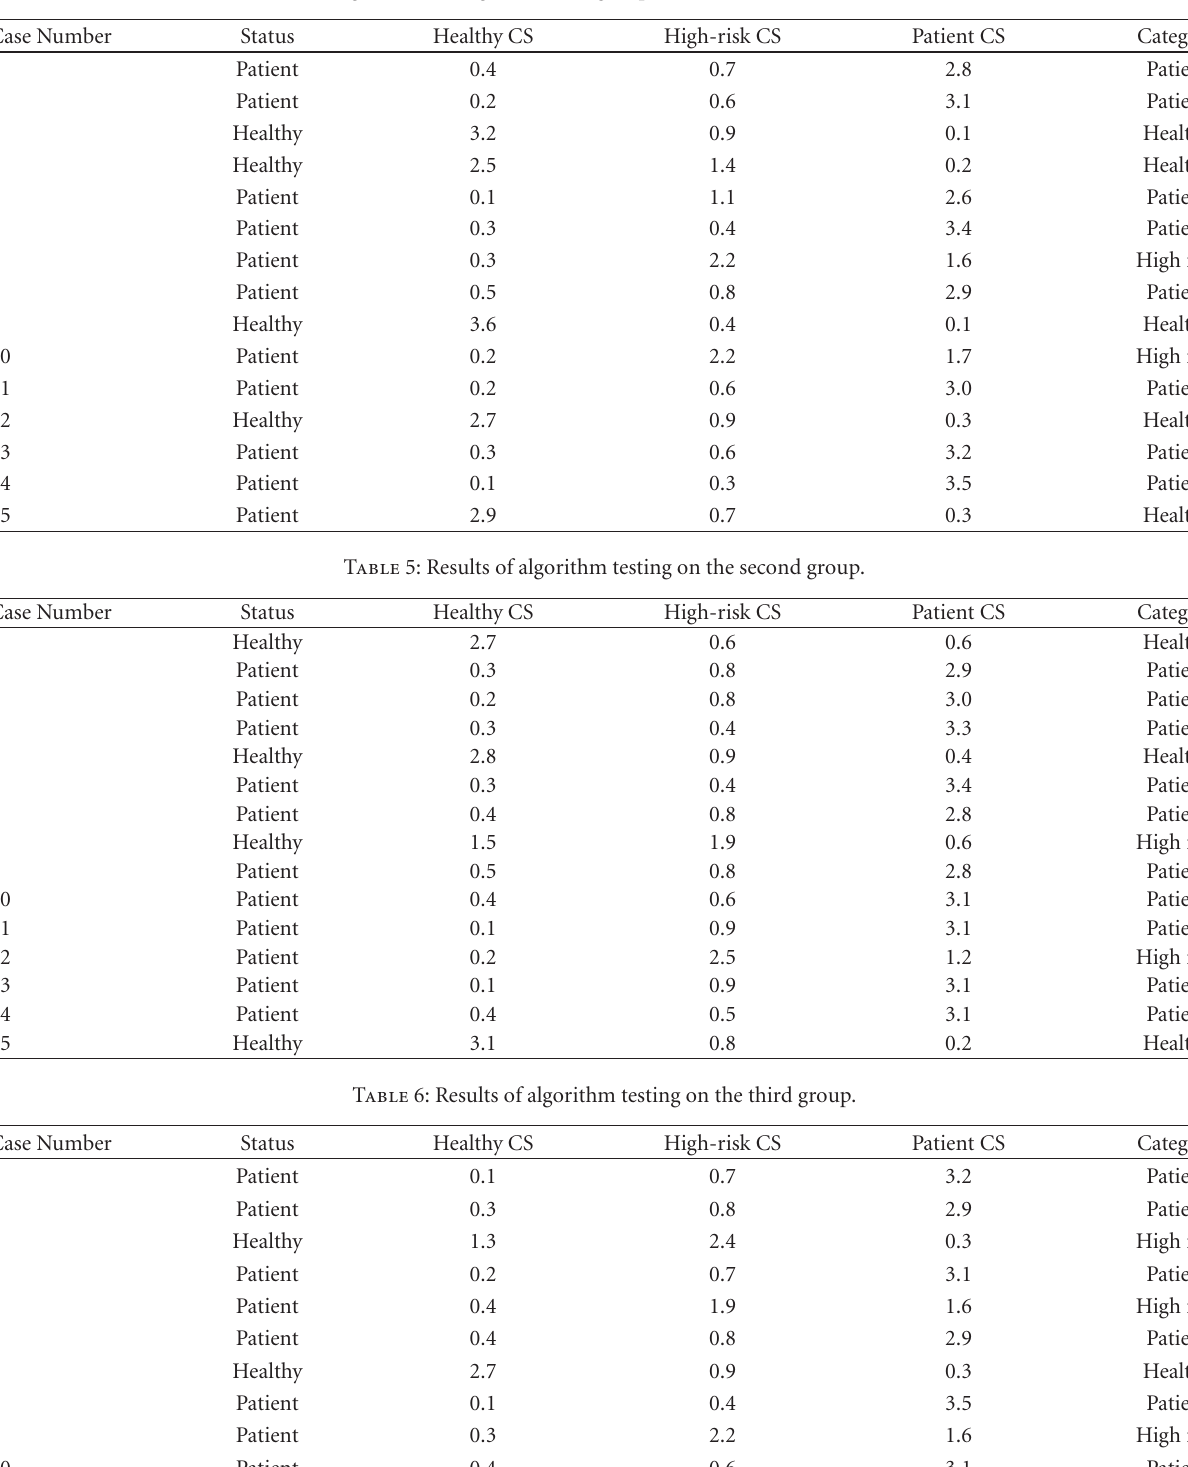
Table 4: Results of algorithm testing on the first group. The CS is abbreviation for cumulative sum.